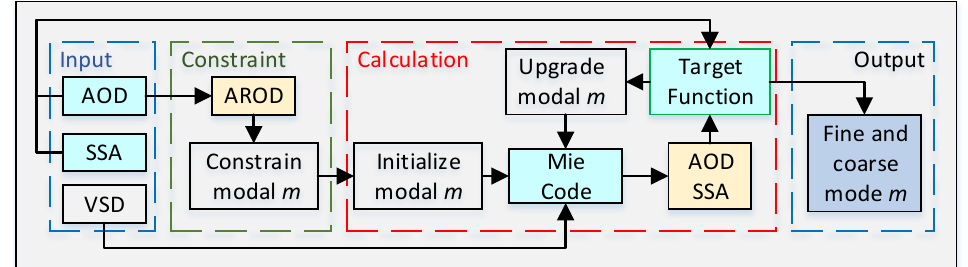
Figure 1. Flow diagram of the general research framework for inferring fine- and coarse-mode complex refractive indices; AOD, SSA, VSD, and AROD represent aerosol optical depth, single scattering albedo, volume size distribution, and aerosol relative refractive index, respectively, modal m donates fine-mode and coarse-mode aerosol refractive index.